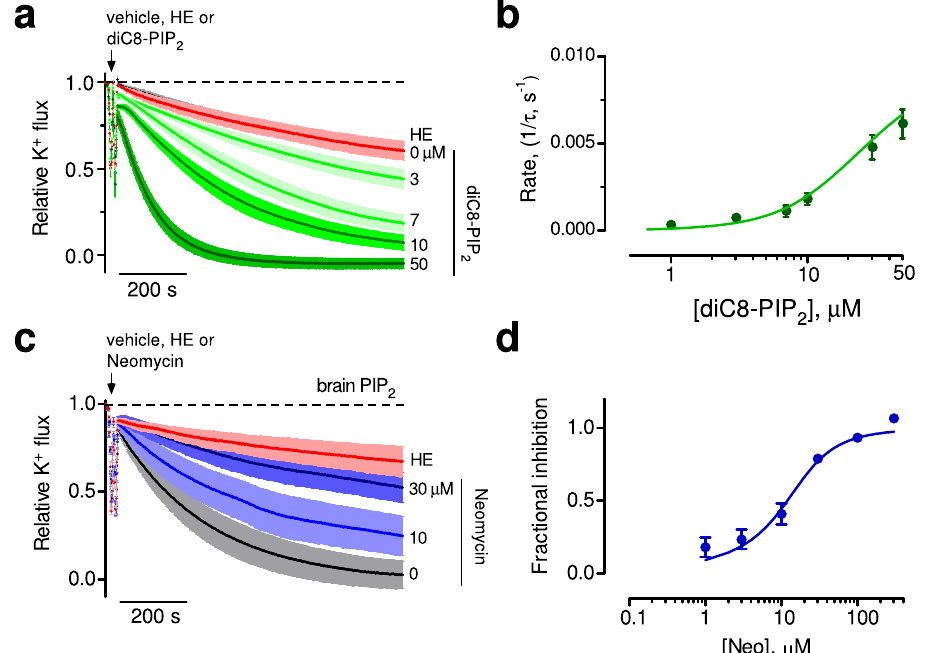
Figure 2. Potency of PIP 2 activation of GIRK2 channels. ( a ) Normalized fluorescent traces (mean ± SEM) show K + flux for GIRK2 following addition of the indicated concentration of diC 8 -PIP 2 or MTS-HE (100 μ M) (n = 9). ( b ) Plot of the rate of K + flux as a function of diC 8 -PIP 2 concentration. Line shows best fit using the Hill equation with apparent EC 50 of 25.1 ± 3.3 μ M and Hill coefficient of 1.7 ± 0.1 (n = 10). ( c ) Normalized fluorescent traces (mean ± SEM) show K + flux for GIRK2-containing liposomes with 1% brain PIP 2 upon addition of the indicated concentration of neomycin, a competitive inhibitor of PIP 2 (n = 4). ( d ) Plot of the fractional inhibition of K + flux as a function of neomycin concentration. Fraction inhibition was calculated using the apparent steady-state K + flux measurement. Line shows best fit using the Hill equation with IC 50 for neomycin inhibition 11.1 ± 2.4 μ M and with a Hill coefficient of 1.3 ± 0.3 (n =